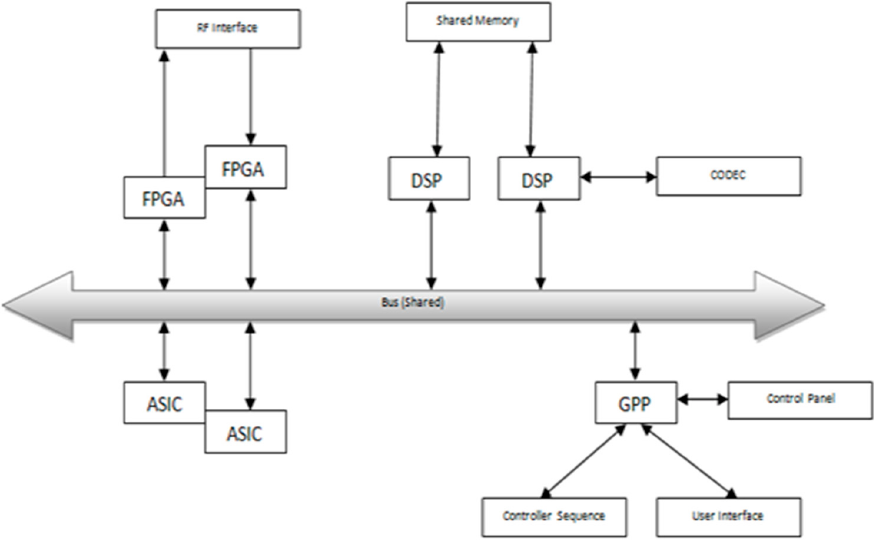
Figure 18. Digital signal processing embedded communication system interfaces.